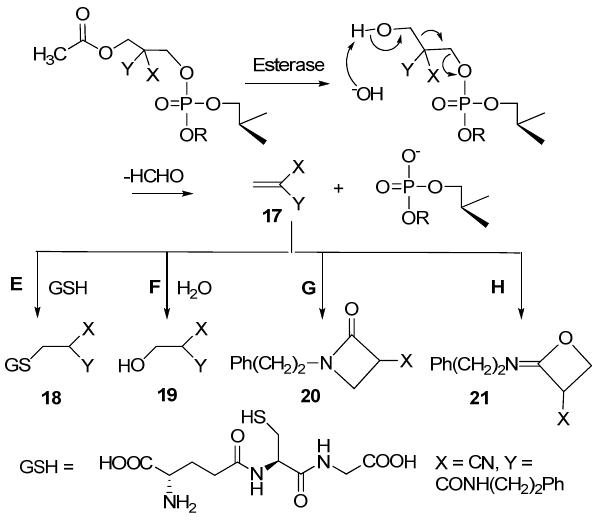
phenyl)ethylacrylamide ( 17 ) by-product